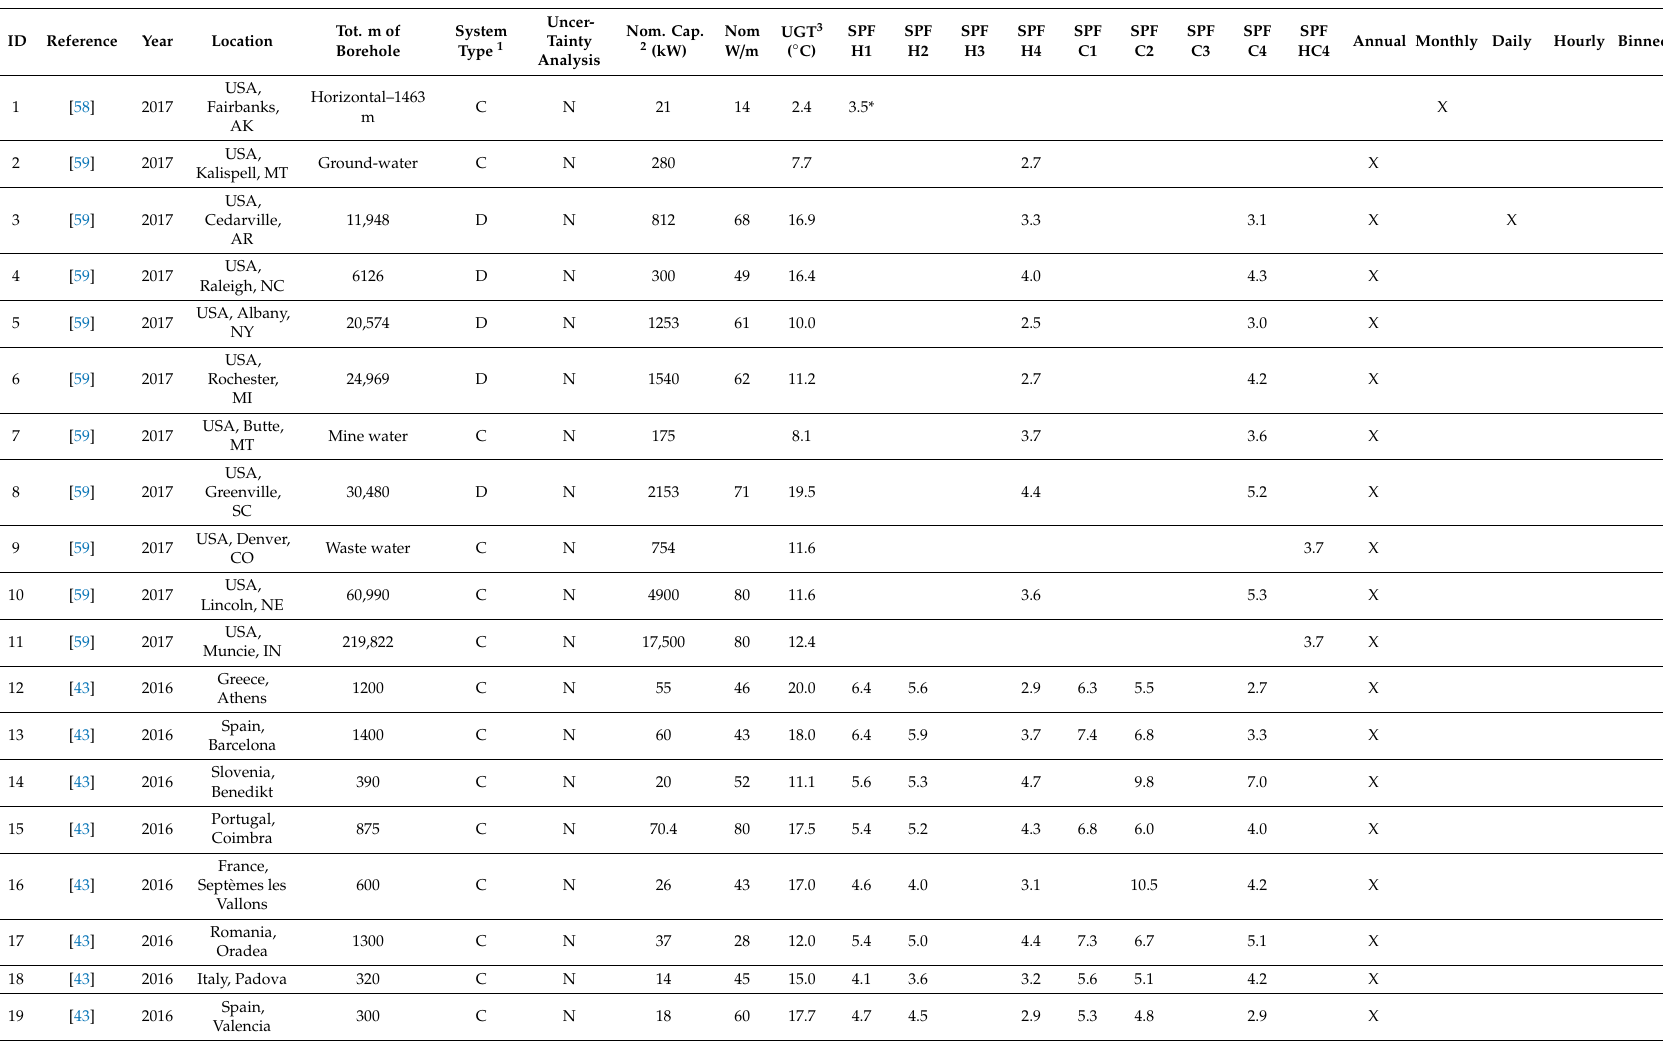
Table 2. SPF and coe ffi cient of performance (COP) values for ground source heat pump (GSHP) systems in commercial or multifamily residential